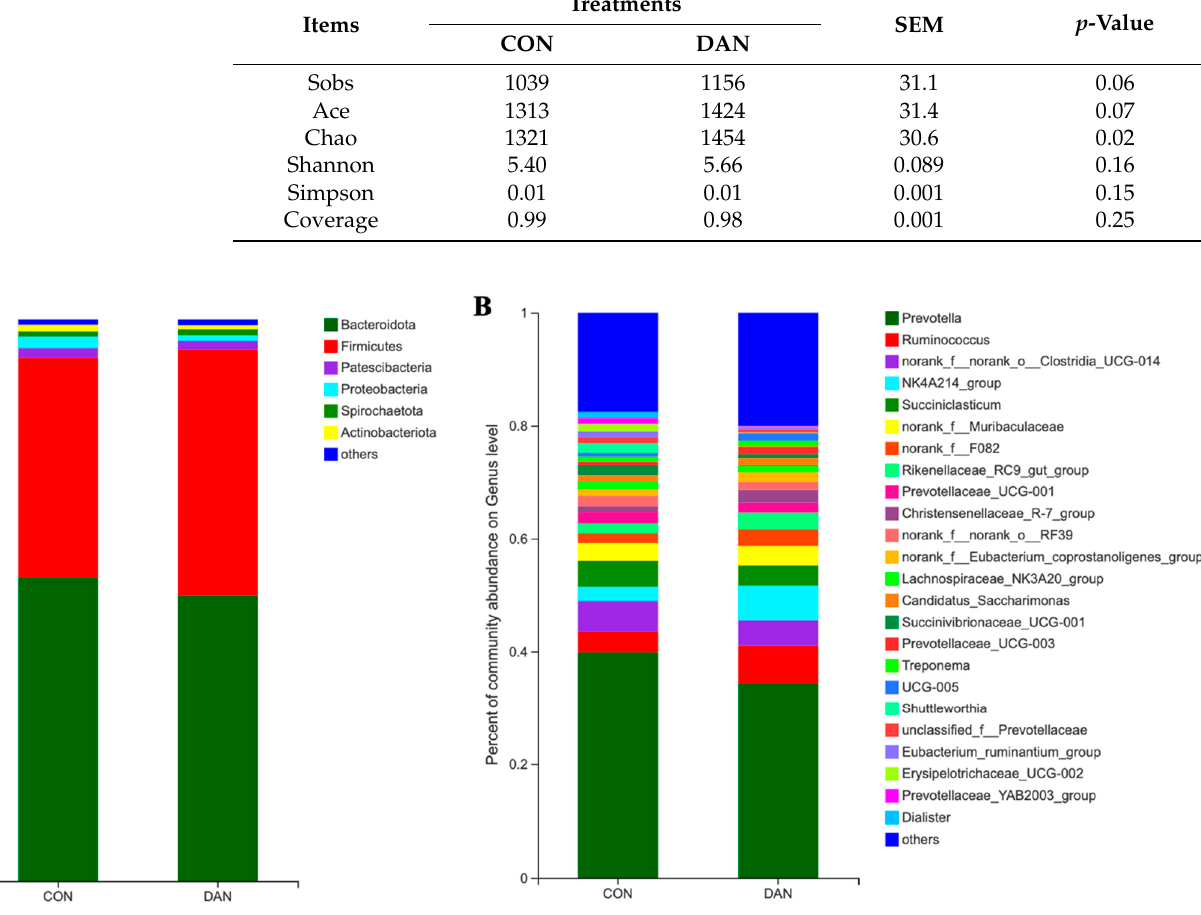
Table 4. Alpha diversity of ruminal bacteria community in mid-lactation dairy cows fed control (CON) and dandelion (DAN) diets.